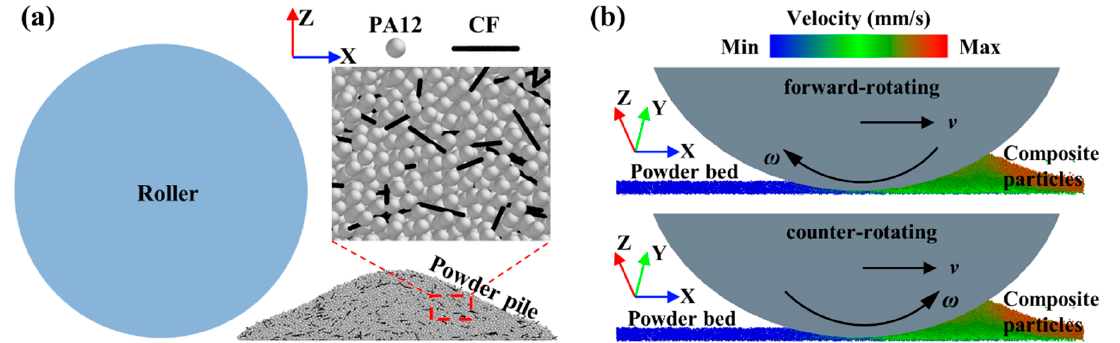
Figure 2. Composite particle spreading process: ( a ) generated PA12/CF composite particles; ( b ) composite particle spreading with different roller rotation patterns.